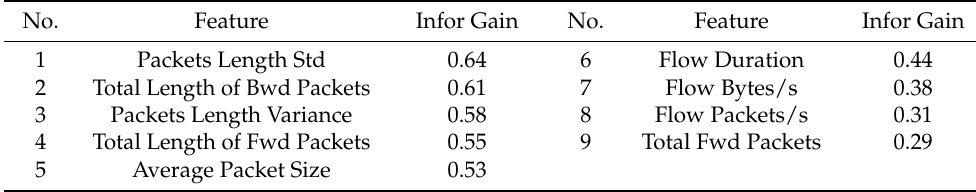
Table 1. Attributive features of each node.